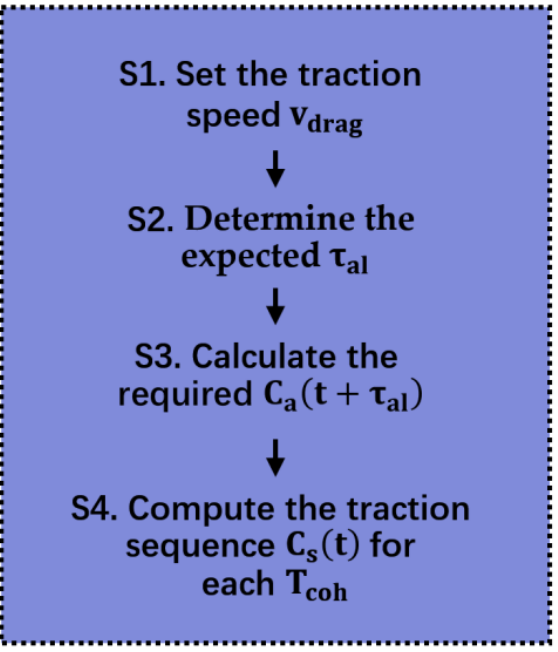
Figure 7. Process diagram of the generation of traction code.